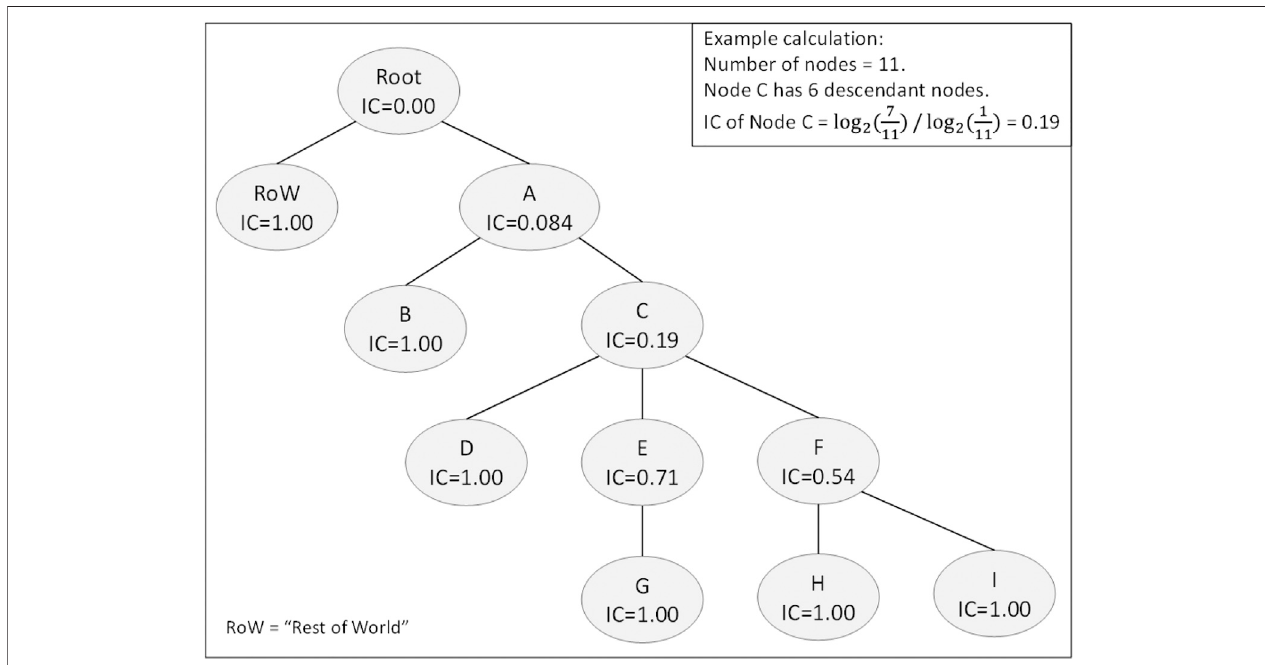
FIGURE4| ExampleontologyICcalculation.ThetreediagramdepictsanexampleontologywithICvaluescalculatedforeachnode.TheRoW(RestofWorld)node designates any entities not represented in ECO. An example of IC calculation for node C is shown in the top-right inset.